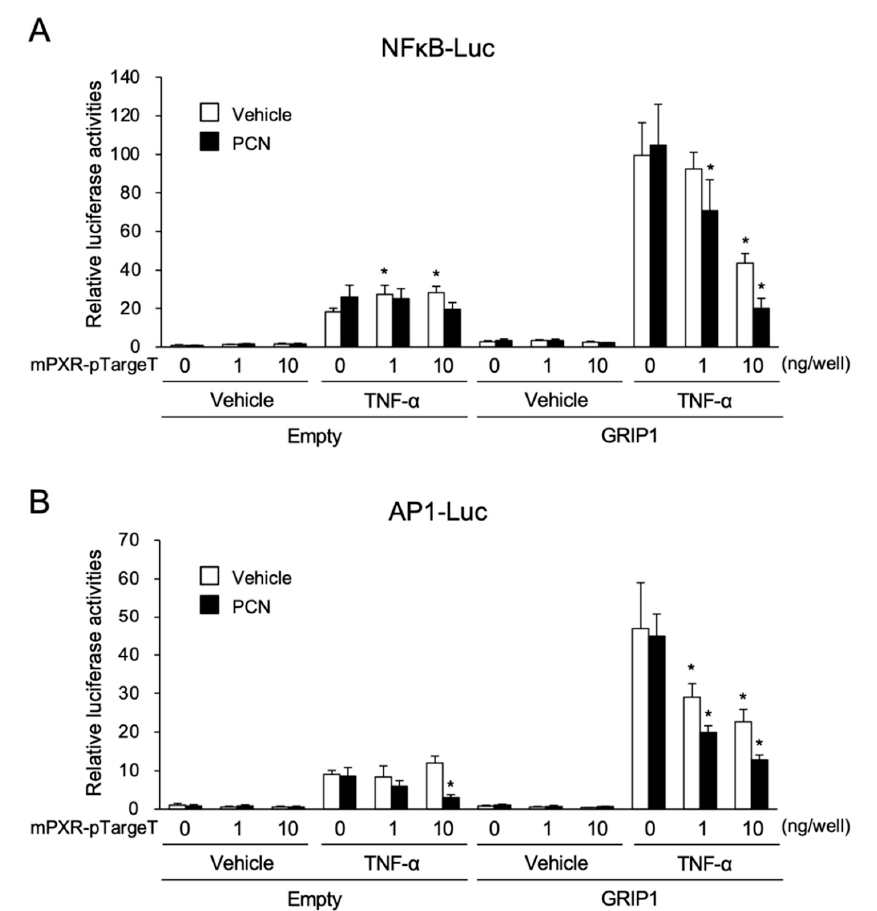
Figure 6. Effect of PXR on NF- κ B- and AP-1-mediated gene transcription. 293T cells were transfected with NF κ B-Luc ( A ) or AP1-Luc ( B ), mPXR and/or GRIP1 expression plasmid and/or their control plasmid (pTargeT and/or pFN21A), and control phRL-TK (total DNA: 100 ng/well). The cells were treated with 10 ng/mL TNF- α or 10 nM PMA in combination with or without 10 μ M PCN or vehicle (0.1% DMSO) for 24 h, and reporter activity was determined. Relative activity is shown compared to that in the cells transfected with control plasmid and treated with vehicle only (the left-end open bar) as 1. Values are presented as mean ± SD ( n = 4). Statistical differences within the TNF- α -treated groups were tested using one-way ANOVA followed by Dunnett’s test, with the vehicle-treated cells with no PXR expression (the far-left column) as a control group. * p < 0.05.